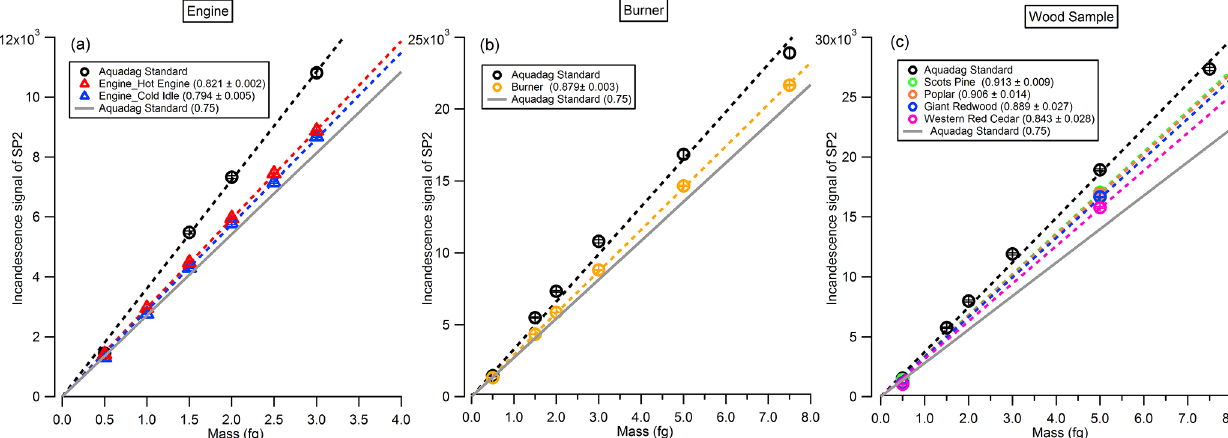
Figure 4. The incandescence signal of the SP2 as a function of the rBC mass. BC particles were selected by the CPMA from (a) engine emission, (b) burner emission or (c) wood combustion emission.